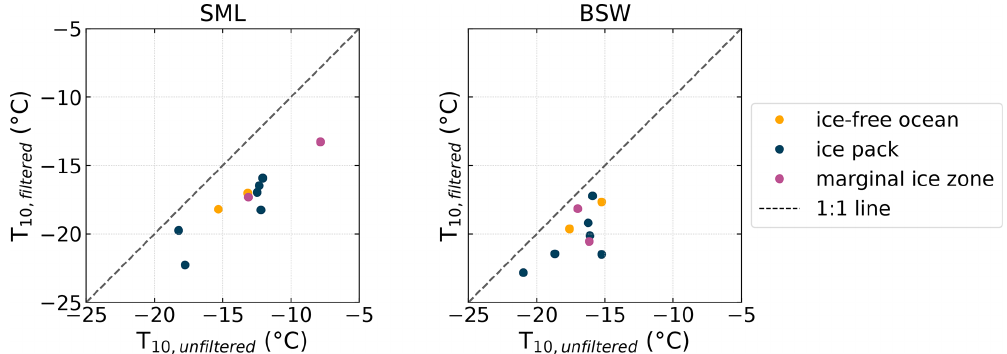
Figure 7. Comparison of filtered and unfiltered SML and BSW samples measured with INDA. Shown are the T 10 values for corresponding samples. Symbols below the 1 : 1 line indicate that the filtered sample is less ice active.